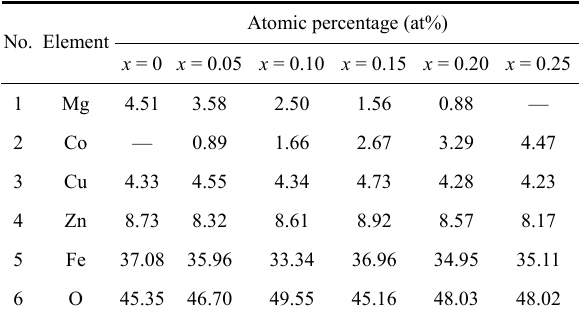
Table 2 Elemental composition obtained from EDS data for ferrites Atomic percentage (at%) No. Element